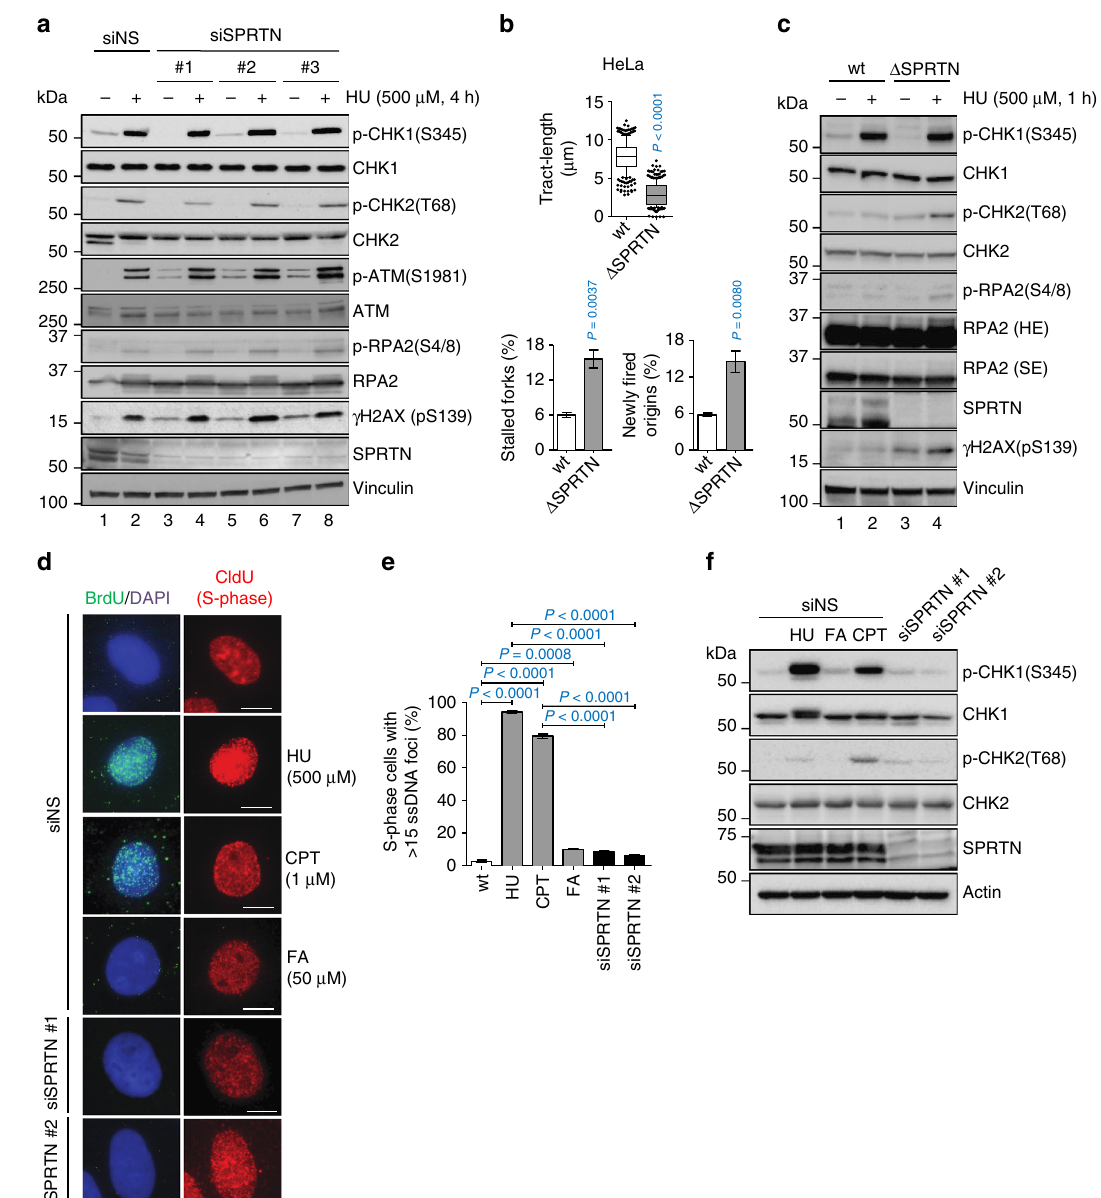
Fig. 3 SPRTN does not contribute to the activation of CHK1 after DSB formation. a Phosphorylation status of the ATR-CHK1 and ATM-CHK2 pathways in control (siNS) and siRNA SPRTN-depleted HEK293 cells under unchallenged condition or when cells were treated with hydroxyurea (HU). Whole cell extracts were used for the immunoblots. b DNA fi ber assay analysis comparing HeLa-wt ( wild type , parental) and HeLa- Δ SPRTN cells: quanti fi cation of replication fork velocity (top; mean ± 25 – 75 percentile range (box) ± 10 – 90 percentile range (whiskers)), newly fi red origins (bottom left; mean ± SEM) and stalled replication forks (bottom right; mean ± SEM). >100 DNA fi bers were analysed per condition and experiment; n = 3 experimental replicates, two- tailed Student's t -test. c Analysis of the phosphorylation status of the ATR-CHK1 and ATM-CHK2 pathways comparing HeLa - wt and - Δ SPRTN under unchallenged or HU-treated conditions. Whole cell extracts were used for the immunoblots. SE: short exposure; LE: long exposure. d , e SPRTN-de fi cient (siSPRTN) or wt cells (siNS) treated with formaldehyde (FA; 50 μ M, 1 h) do not exhibit robust single-stranded DNA foci in S-phase cells (CldU positive). HU (500 μ M, 1 h) was used as a positive control to generate replication stress-induced ssDNA formation. Camptothecin (CPT, 1 μ M, 1 h followed by 1 h recovery) was used as a positive control for ssDNA formation induced by DSBs. Data are shown as representative immuno fl uorescent microscopy images of BrdU foci (ssDNA) in S-phase (CldU positive) HeLa cells ( d ), and as quanti fi cation of cells with more than 15 BrdU foci ( e ). Scale bar = 10 µ m. >70 individual CldU positive cells were scored per condition per experiment. Mean± SEM; n = 3 experimental replicates, two-tailed Student's t -test. f FA treatment and SPRTN-depletion fail to induce phosphorylation of CHK1 at Ser345 due to the absence of ssDNA formation. HU or CPT were used at the same conditions as in ( d ) as positive controls for ssDNA-induced CHK1 and CHK2 activation. Immunoblots of HeLa cells whole cell extracts shown here represent three experimental replicates. Source data for ( a – c , e , f ) are provided as a Source Data fi